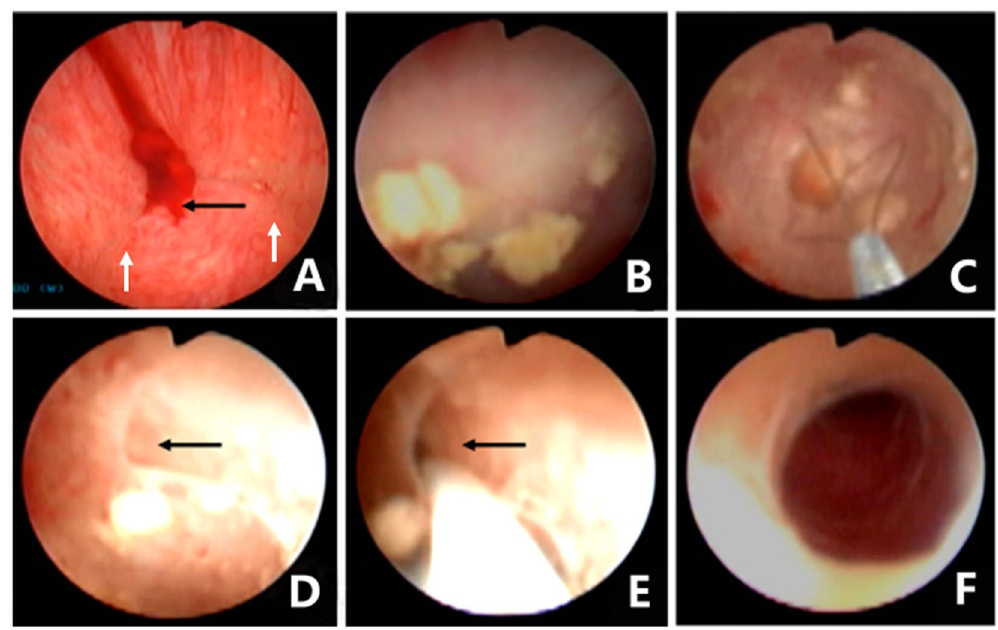
Figure 9. Seminal vesiculoscopy and treatment by the pathological opening in PU. ( A ) Bloody fluid poured from the orifice of the PU upon bilateral seminal vesicle massage, but nothing came from either of the ED orifices (white arrow). ( B ) The seminal vesiculoscope was inserted into the PU, and several stones were found in the PU. ( C ) The stones were removed by grasping forceps. ( D ) There are pathological openings in the PU at the 4 and 8 o’clock area in the PU (showing only the 4 o’clock opening). ( E ) The guidewire can be directly inserted into the SV through the opening. ( F ) The seminal vesiculoscope was inserted into the